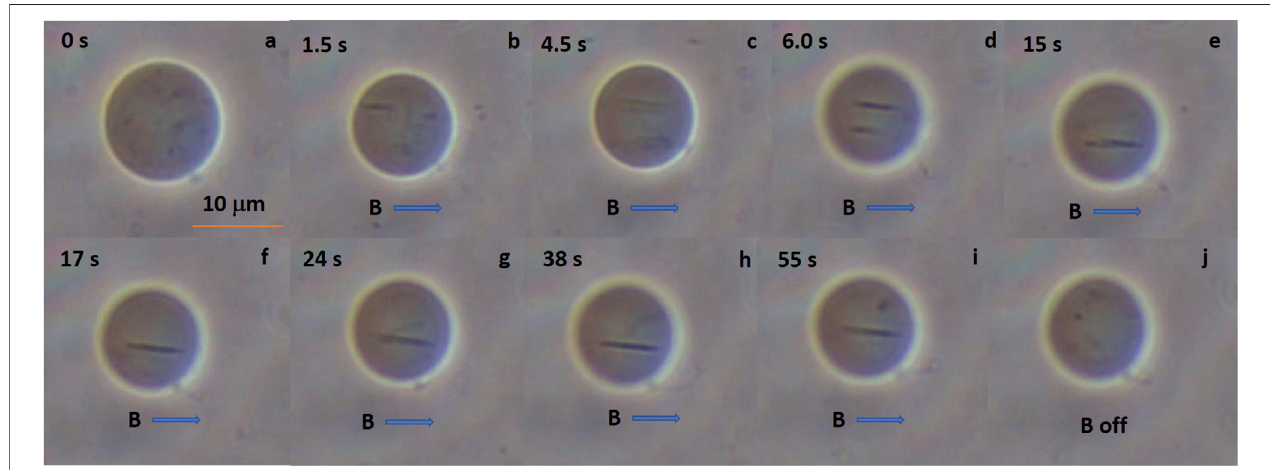
FIGURE 5 | Chain formations inside MLs. When MLs are subjected to DC magnetic fi elds we can see that the small black dots (SNPs aggregates, 1 % SNPs) form chains inside the MLs. (A) shows the MLs when no fi eld is applied, the upper left number is the time counting in seconds. We can see the aggregates swirling inside the MLs. (B) is1.5 safter theDCmagnetic fi eld isapplied.AchainofSNPs isformed afterward, in (C,D) wecansee twochainformations.After 15 sboth chainscollapse in one, in (F) the chain is stable displaying random movement (G – I) . Finally, in J the magnetic fi eld is switched off and the chain is disassembled. We observe MLs for hours and the SNPs aggregates never leaves the MLs either with or without applied DC magnetic fi